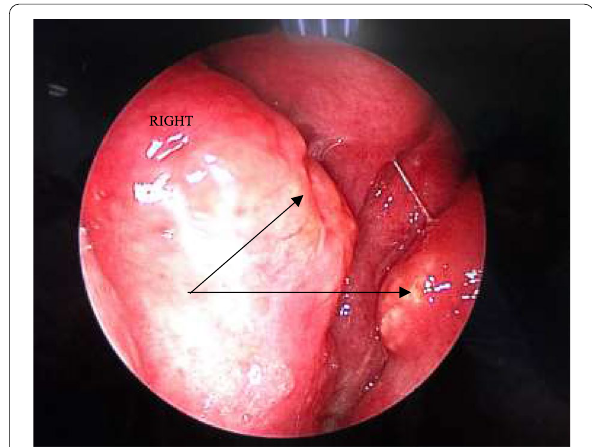
Fig. 1 Endoscopic view of nasopharynx showed the right torus tubarius is more prominent than the left side with irregular yellowish lobulated lesion on the medial surface